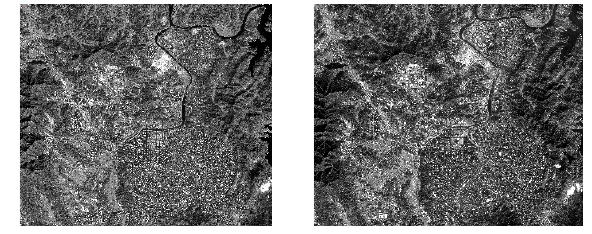
Figure 1. QuickBird stereo pair over Daejeon, Korea Table 1. The properties of the used QuickBird stereo pair.